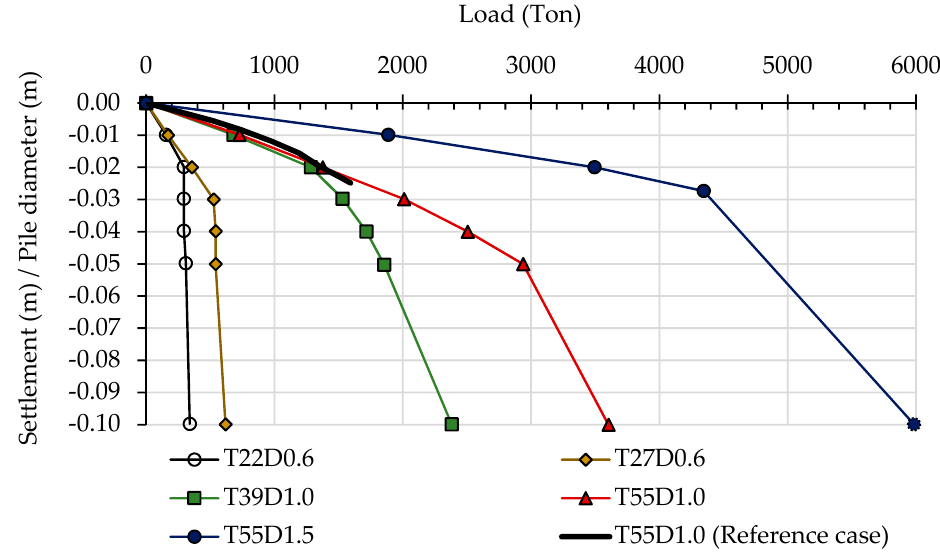
Figure 7. Ultimate Loads vs. settlement.